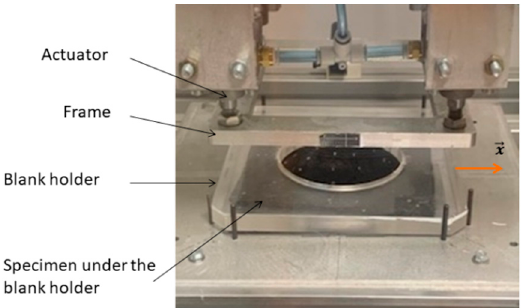
Figure 2. Preforming machine.